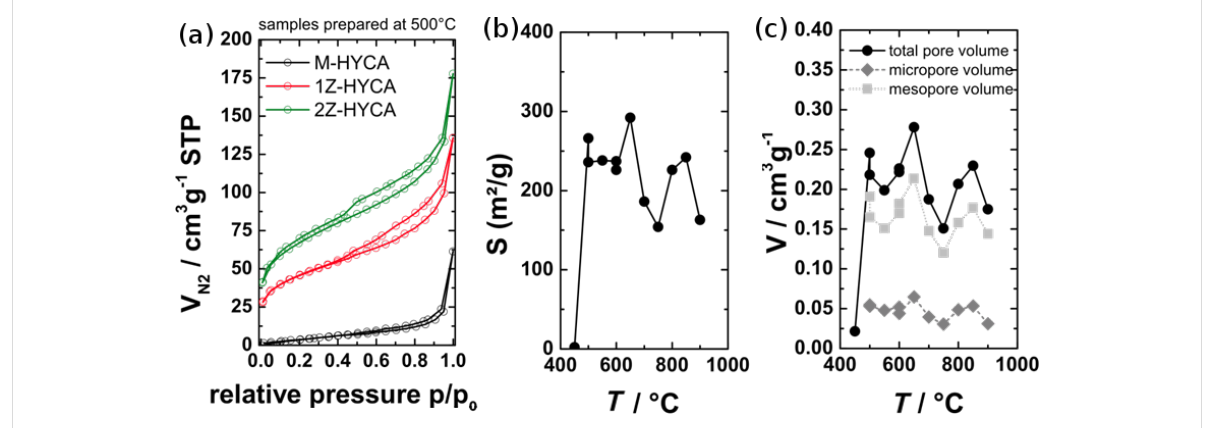
Figure 1: (A) N 2 adsorption/desorption isotherms (77.4 K) for the HYCA materials prepared at 500 °C. (B) BET surface area of the 2Z-HYCA materi- als vs calcination temperature. (C) Pore volumes of the 2Z-HYCA nanocomposite materials vs calcination